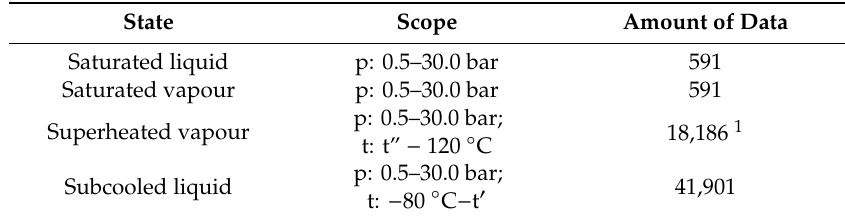
Table 2. The scope of equations describing the properties of the R1234ze(E) refrigerant and the amount of data used for